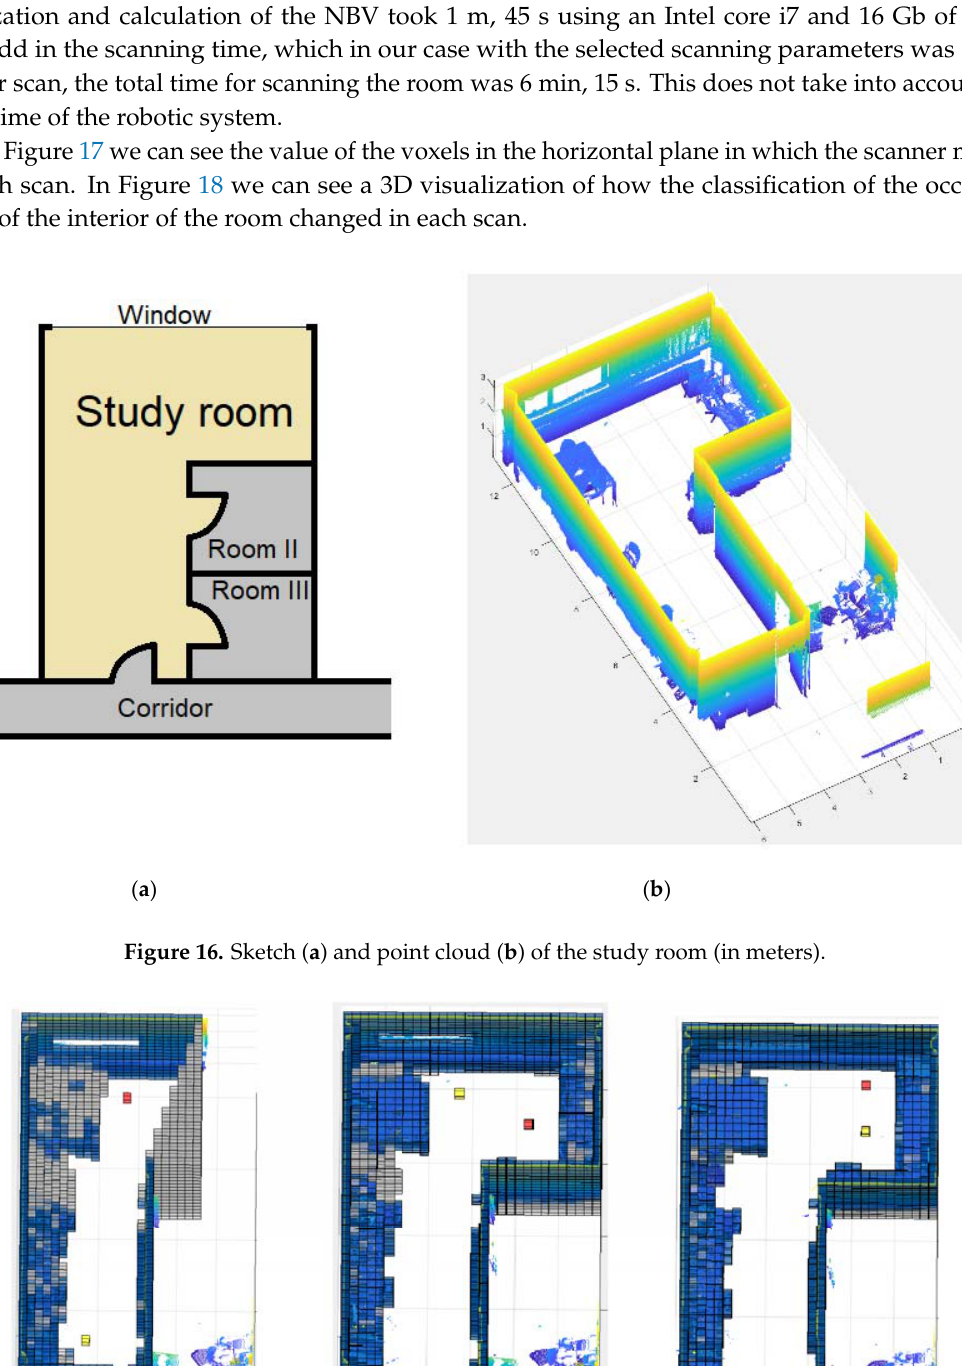
( c ) Figure 18. Horizontal plane of voxels for each scan. Dark blue: occupied; light blue: empty; green: door; magenta: window; grey: occluded; yellow: out; black: scanner position; red: NBV. ( a ) First scan. ( b ) Second scan. ( c ) Third scan. All the algorithms for point cloud processing were implemented in MATLAB 2017b, using the Point Cloud Library. As mentioned before, the scanning process was carried out with a Faro Focus 3D X330 LiDAR scanner. Each point cloud had about 3.8 million points, which, after applying the filtering, remained at about 480,000 points. In Table 1 we can see the percentage of voxels of each type, the total number of voxels and the dimensions of the voxelization matrix for each of the three